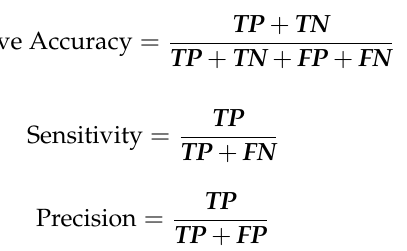
where TP is the number of true positives (actual positives classified as positives), TN is the number of true negatives (actual negatives classified negatives), FP is the number of false positives (actual negatives classified as positives), and FN false negatives (actual positives that are classified as negatives). Boxplots were generated to present the distributions of each performance variable with the bottom and top box edges indicating the 25th and 75th percentiles, respectively, and the red center lines representing the median. Outliers (denoted by red crosses) are defined as any value that is more than 1.5 times the interquartile range outside the box edges.